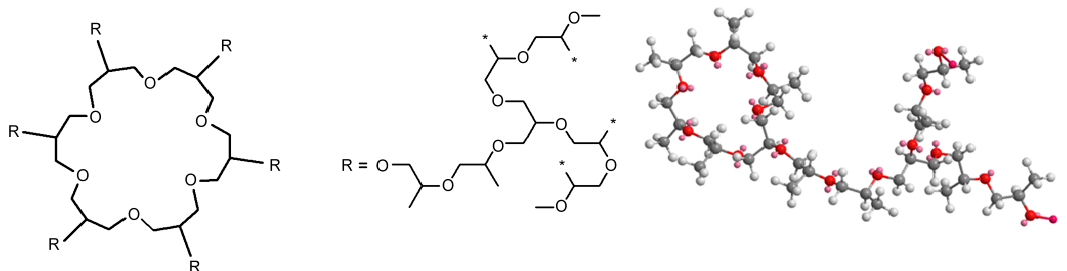
Figure 4. Simplified scheme macromolecule with two branches (* means places of chain growth).